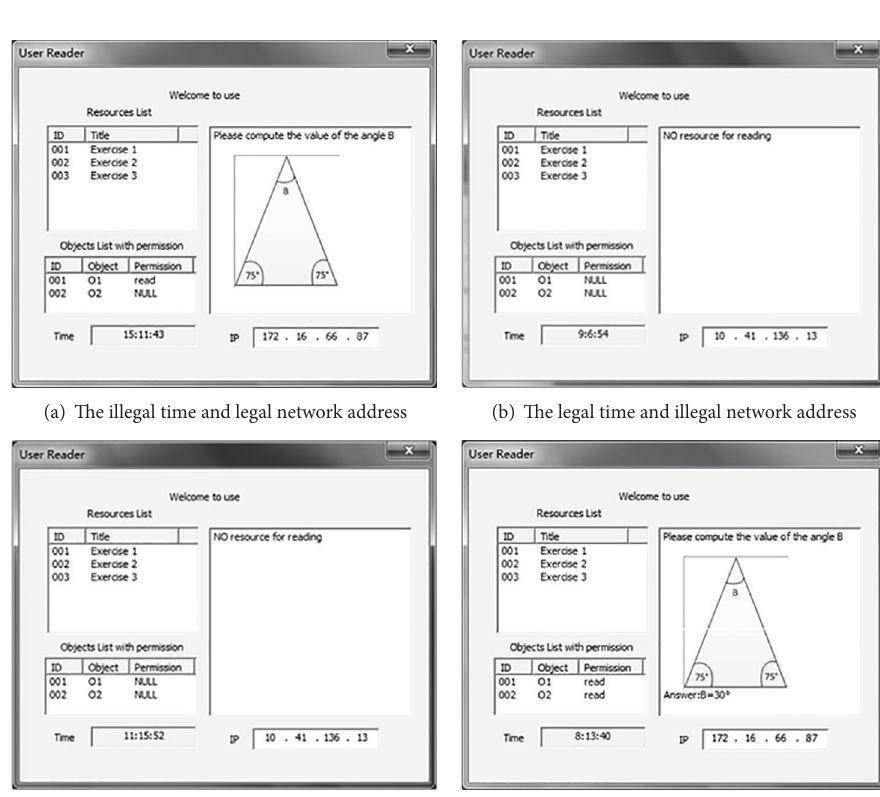
Figure 7: The results of